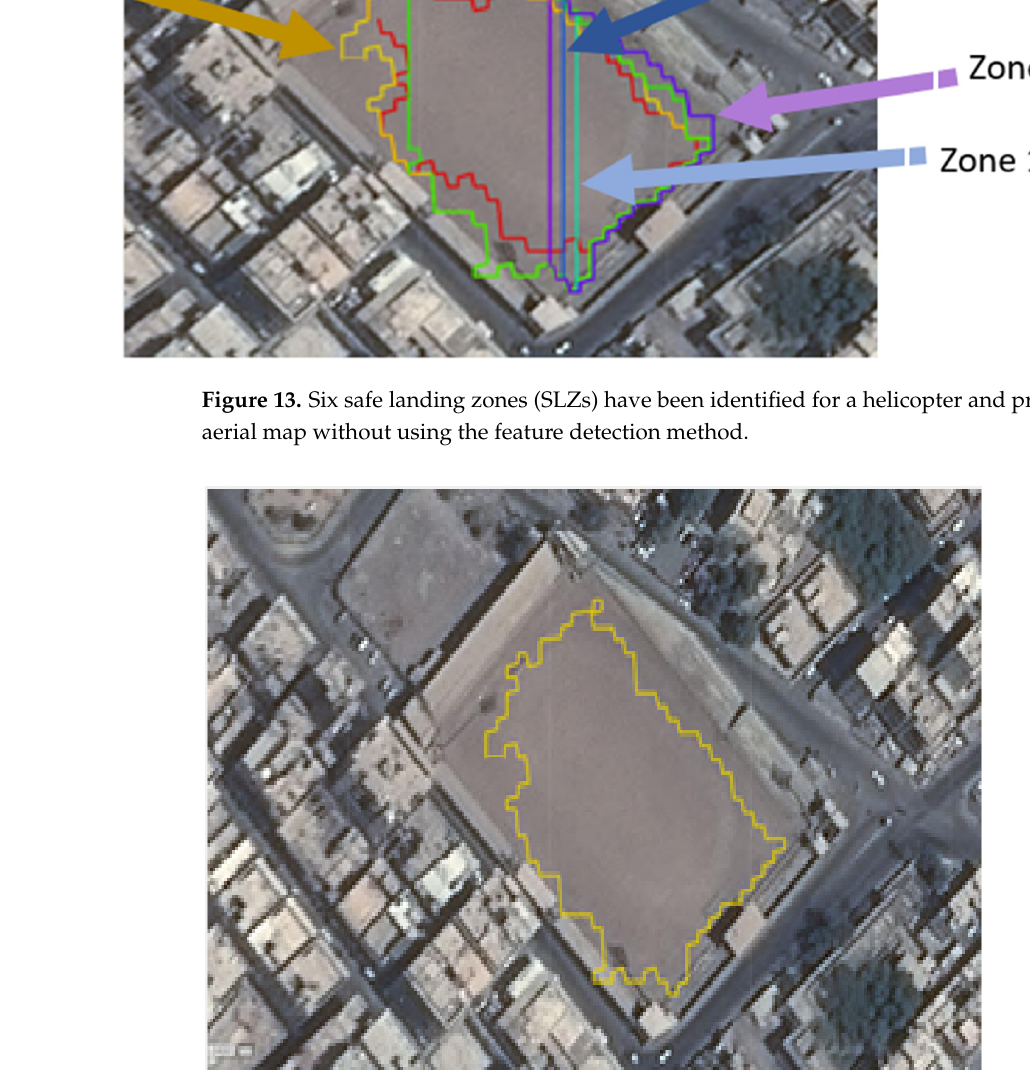
Figure 14. SLZ projected on the aerial map using the feature.